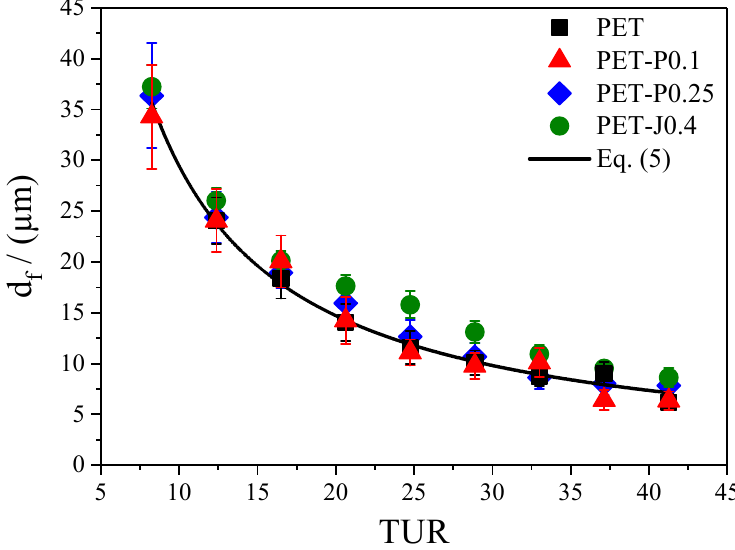
Figure 9. Measured film thickness d f as a function of take-up ratio TUR for PET modified with PMDA or Joncryl in comparison to the data calculated according to Equation (5).